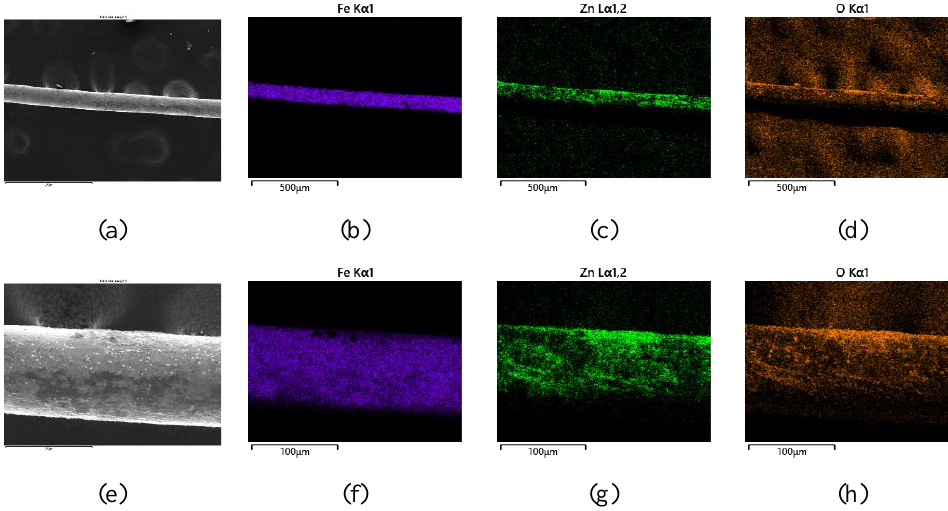
Figure 11. SEM-EDX analysis of the amorphous fibres coated via the hydrothermal technique using a precursor solution of 0.05M concentration and a deposition duration of 24 h. ( a , e ) are SEM images of the plane and semi-circular surface of the fibres; ( b – d ) and ( f – h ) are distribution maps of the Fe, Zn and O on the plane and semi-circular surface of the fibres.